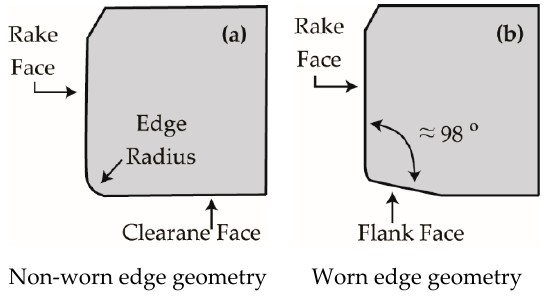
Figure 3. Cutting conditions in the range of cutting parameters. Figure 4. Schematics of edge geometries: ( a ) non-worn and ( b ) worn edge geometries.